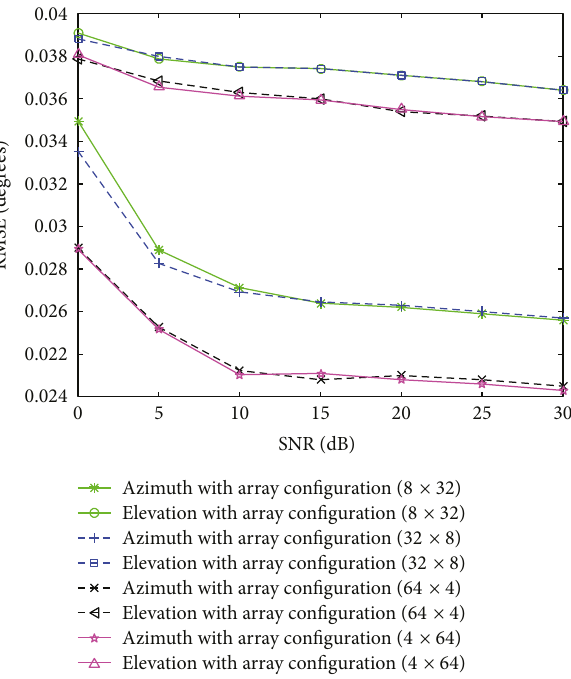
Figure 5: RMSE comparison between elevation and azimuth of fi ve sources with eight types of array con fi